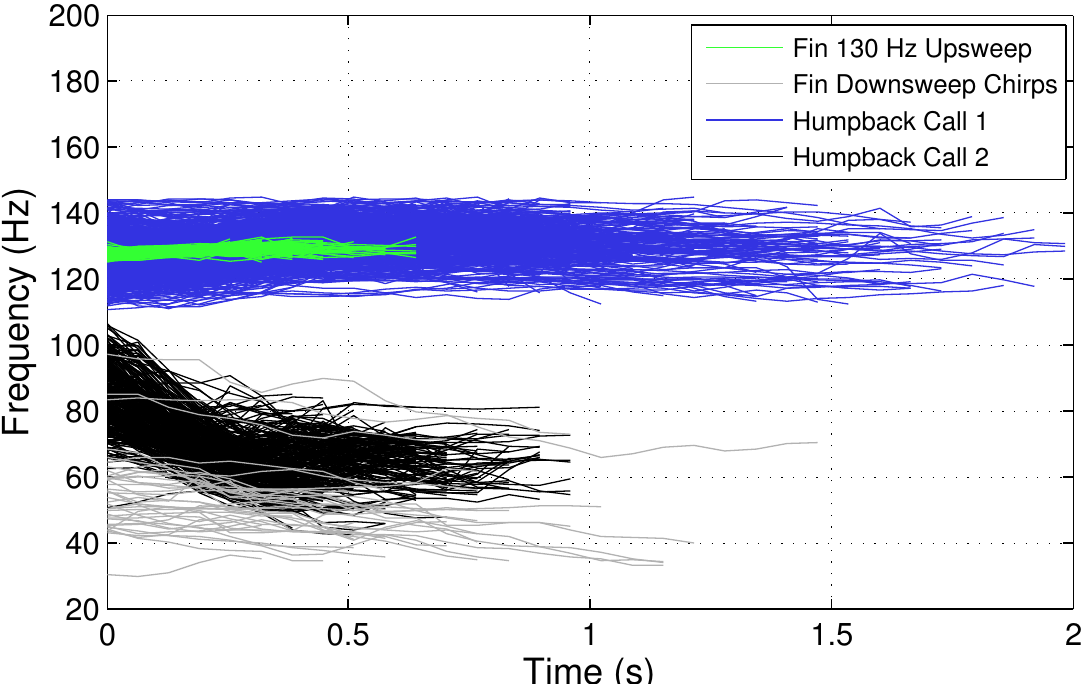
Figure 3. Pitch-track comparisons between several common types of humpback whale and fin whale vocalizations observed during the NorEx14. A pitch-track describes the time variation of the fundamental frequency in the signal. The pitch-tracks for humpback call 1, humpback call 2, and the fin whale 130 Hz upsweep were extracted from POAWRS detections observed off the coast of Lofoten, Norway on 5 March 2014. The fin whale 30–100 Hz downsweeps were extracted from POAWRS detections observed off the coast of Alesund, Norway on 20 February 2014 and off the coast of Lofoten, Norway on 7 March